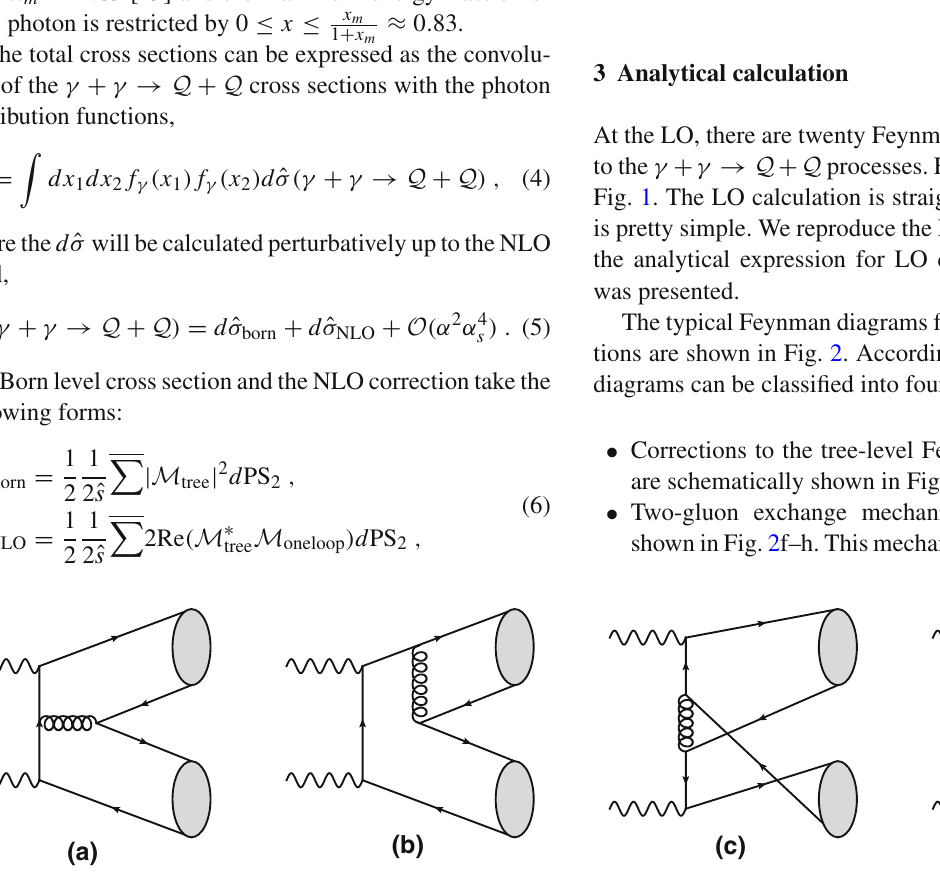
Fig. 1 Typical LO Feynman diagrams for quarkonium-pair production via photon–photon